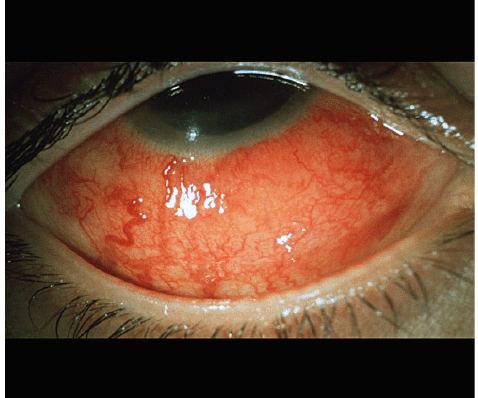
Figure 1 Anterior diffuse scleritis (source: http//www.redatlas.